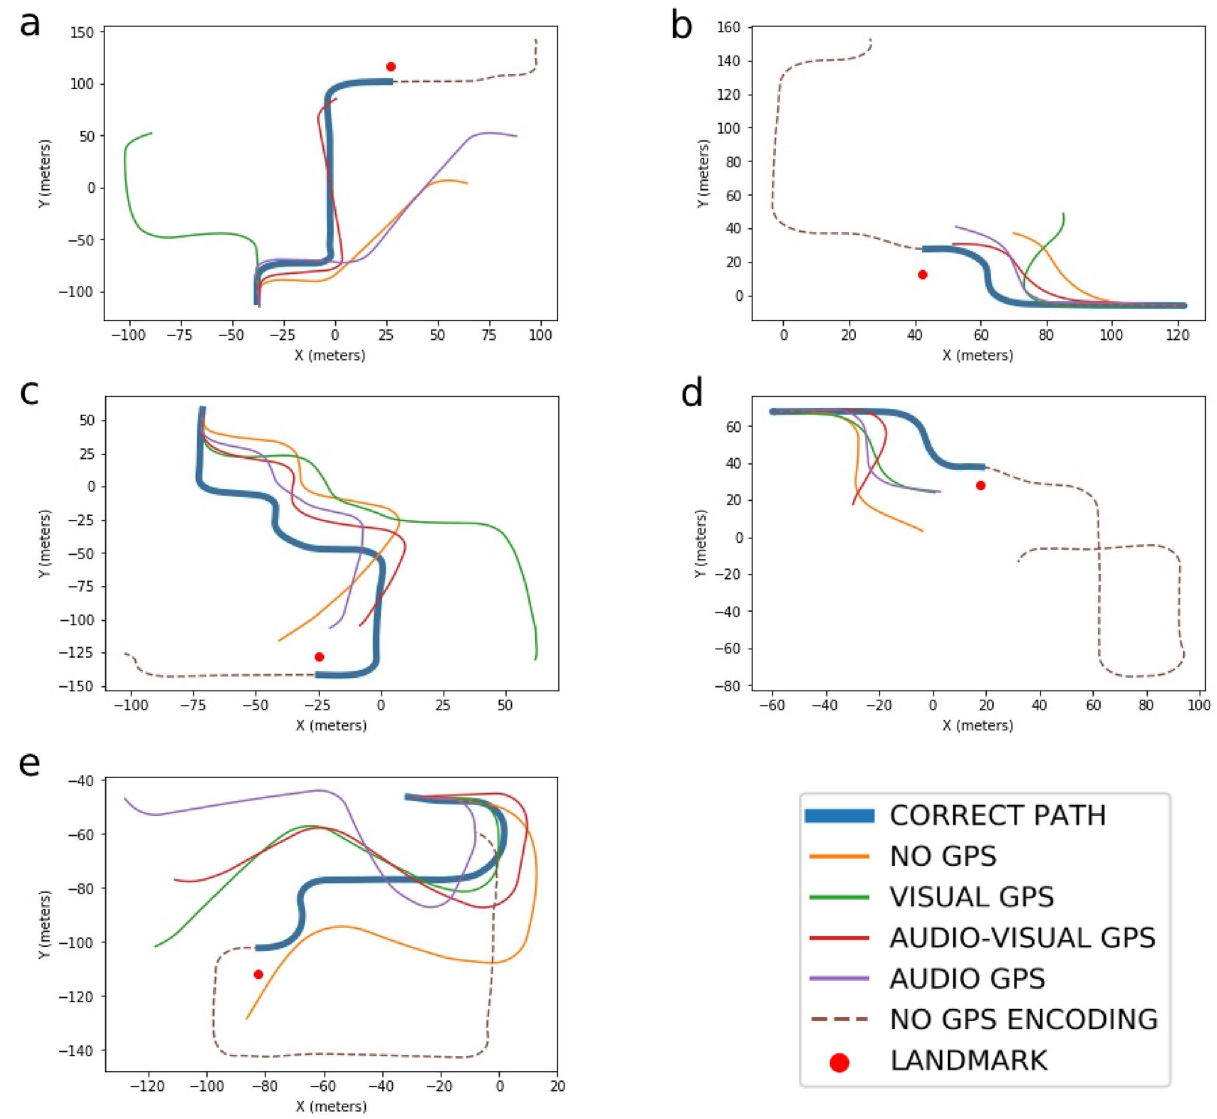
landmark of the route. ( a ) matches the route shown in Fig.